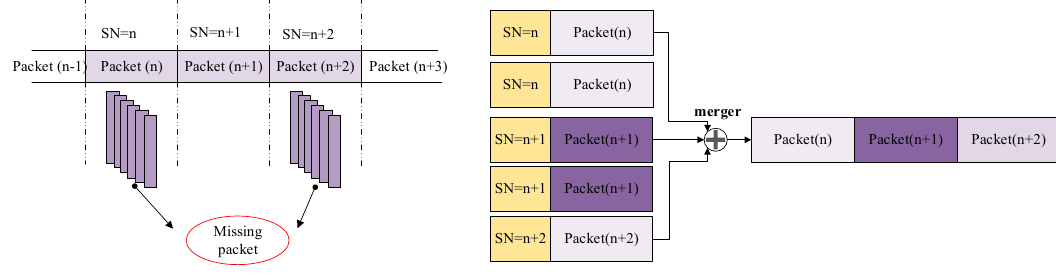
Figure 5. Detection of lost packets and merging packet method using sequence number .